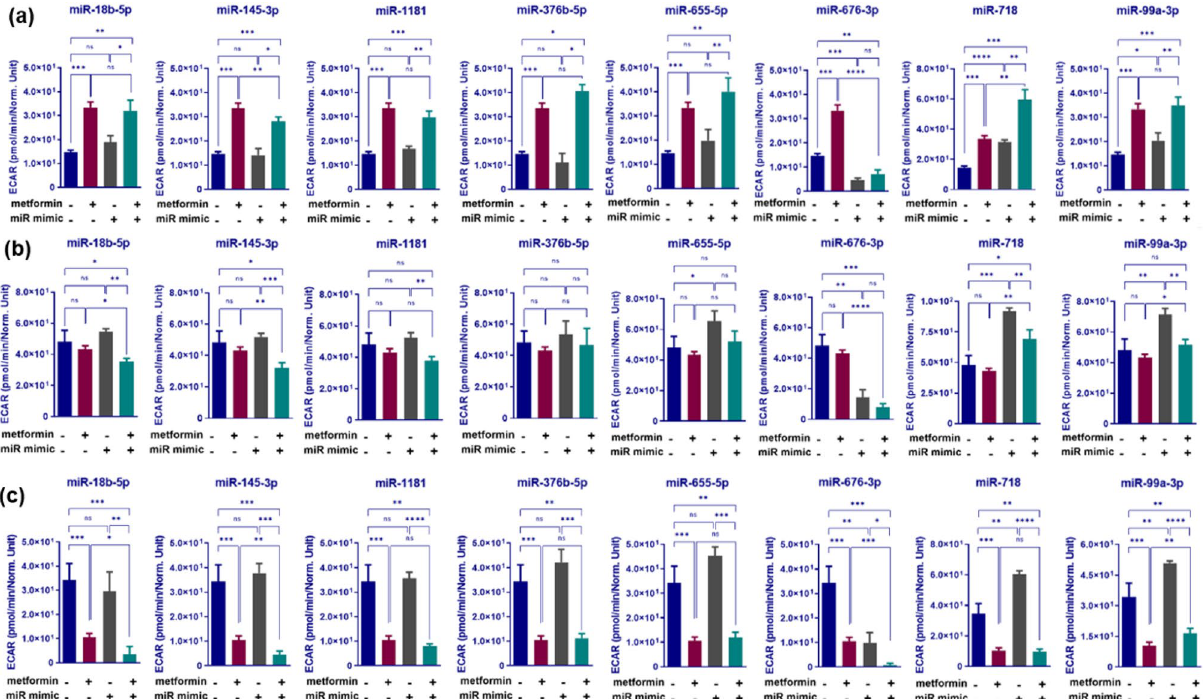
Figure 3. Changes in glycolysis ( a ), maximum glycolytic capacity ( b ) and glycolytic reserve ( c ) associated with miRNA mimic transfections in combination with metformin treatment of HCT116 cells. CRC cells were reverse transfected with selected miRNA mimics and treated with 2.5 mM metformin or control medium. Extracellular acidification rate (ECAR) of the cells was determined over a 30-min period using a Seahorse XFe-96 Instrument. The ECAR values were normalized to viability of the cells per group determined by crystal violet assay. Results are expressed as mean ± SD of 3 culture replicates and the statistical significance is indicated with asterisks (ns P > 0.05, *P ≤ 0.05, **P ≤ 0.01, ***P ≤ 0.001, ****P ≤